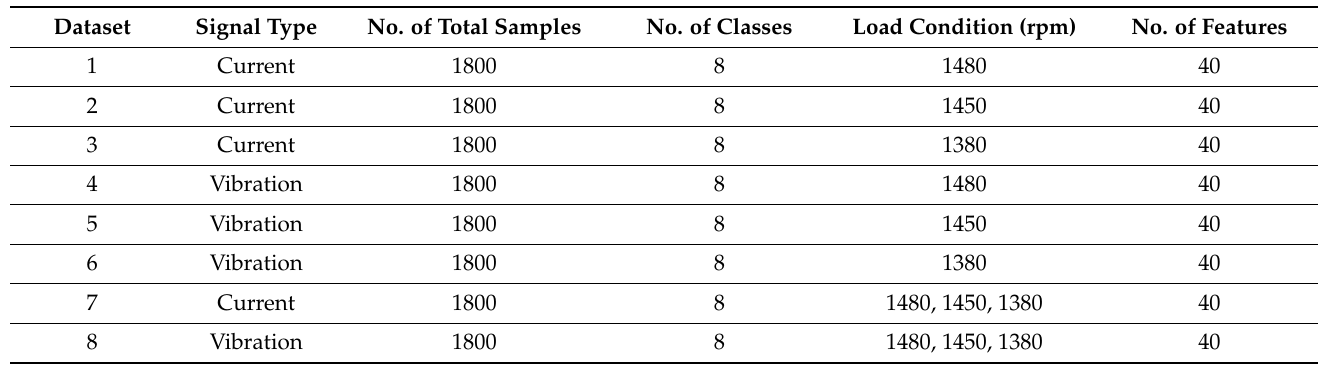
Figure 6. Discrete Wavelet Transform (DWT) processing vibration signal under a One-Broken Rotor Bar fault with speed 1480 rpm. Table 3. Description of